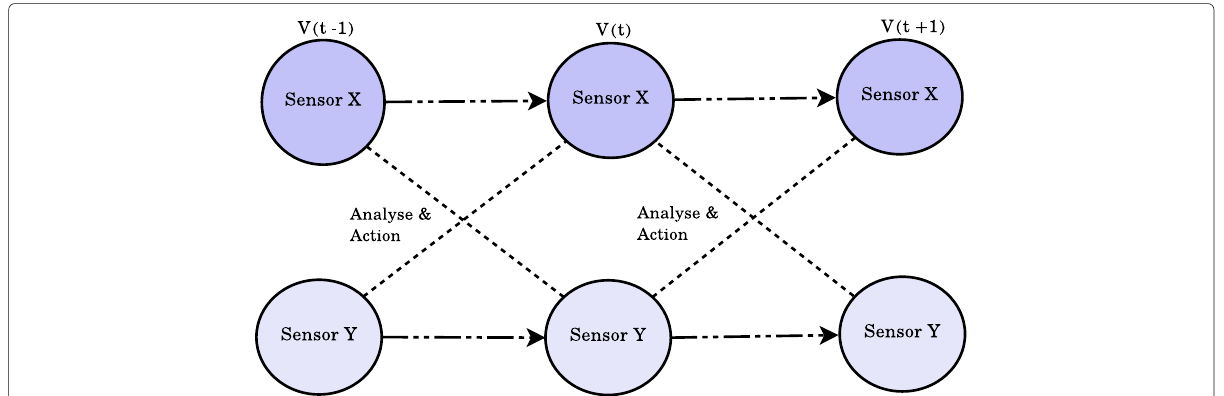
Fig. 4 Flow Process in the CEP Engine that Analyses Data from Different Sensors at Different Fractions of Time.